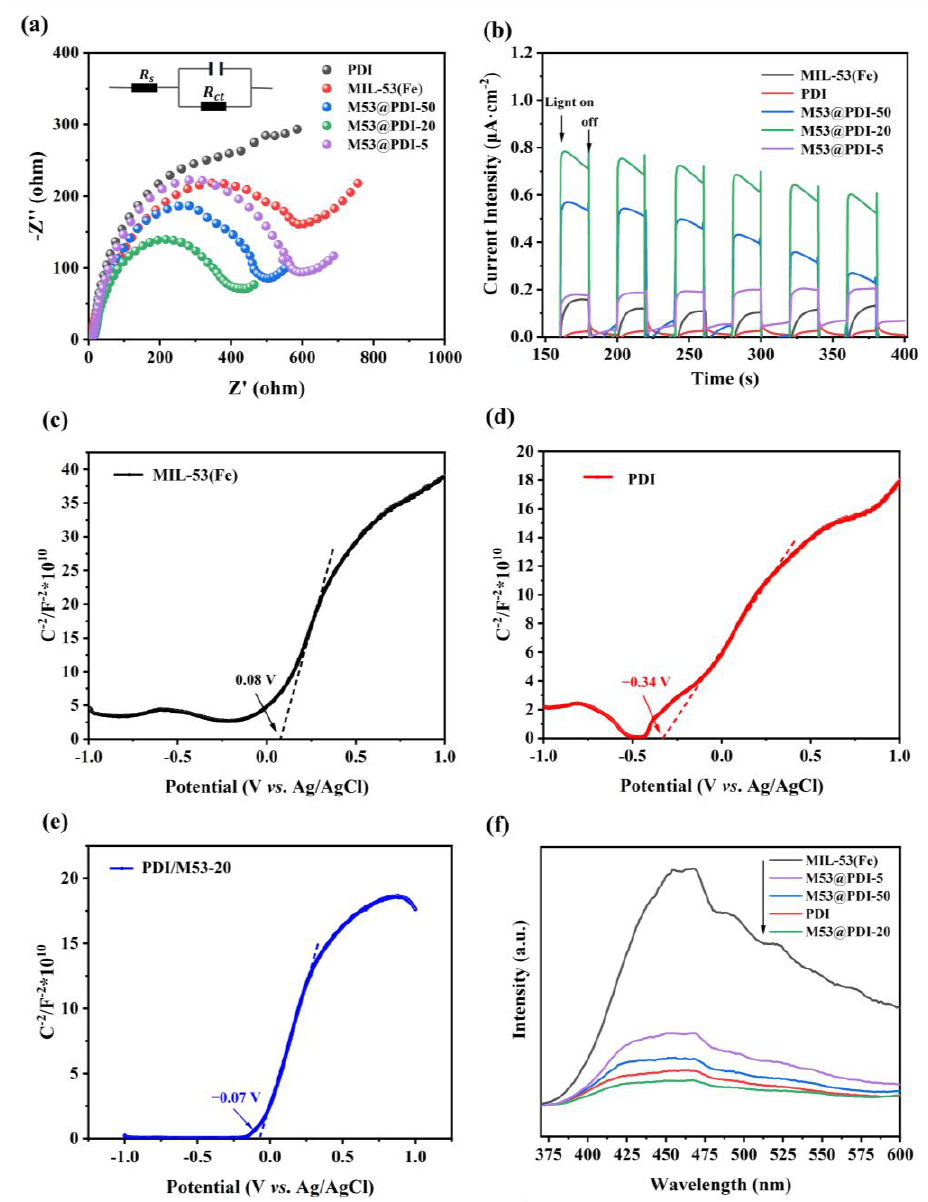
Figure 7. ( a ) EIS Nyquist plots and ( b ) transient photocurrent responses of the samples, Mott–Schottky plots of ( c ) MIL-53(Fe), ( d ) PDI and ( e ) M53@PDI-20 and ( f ) the steady-state photoluminescence (PL) spectra.